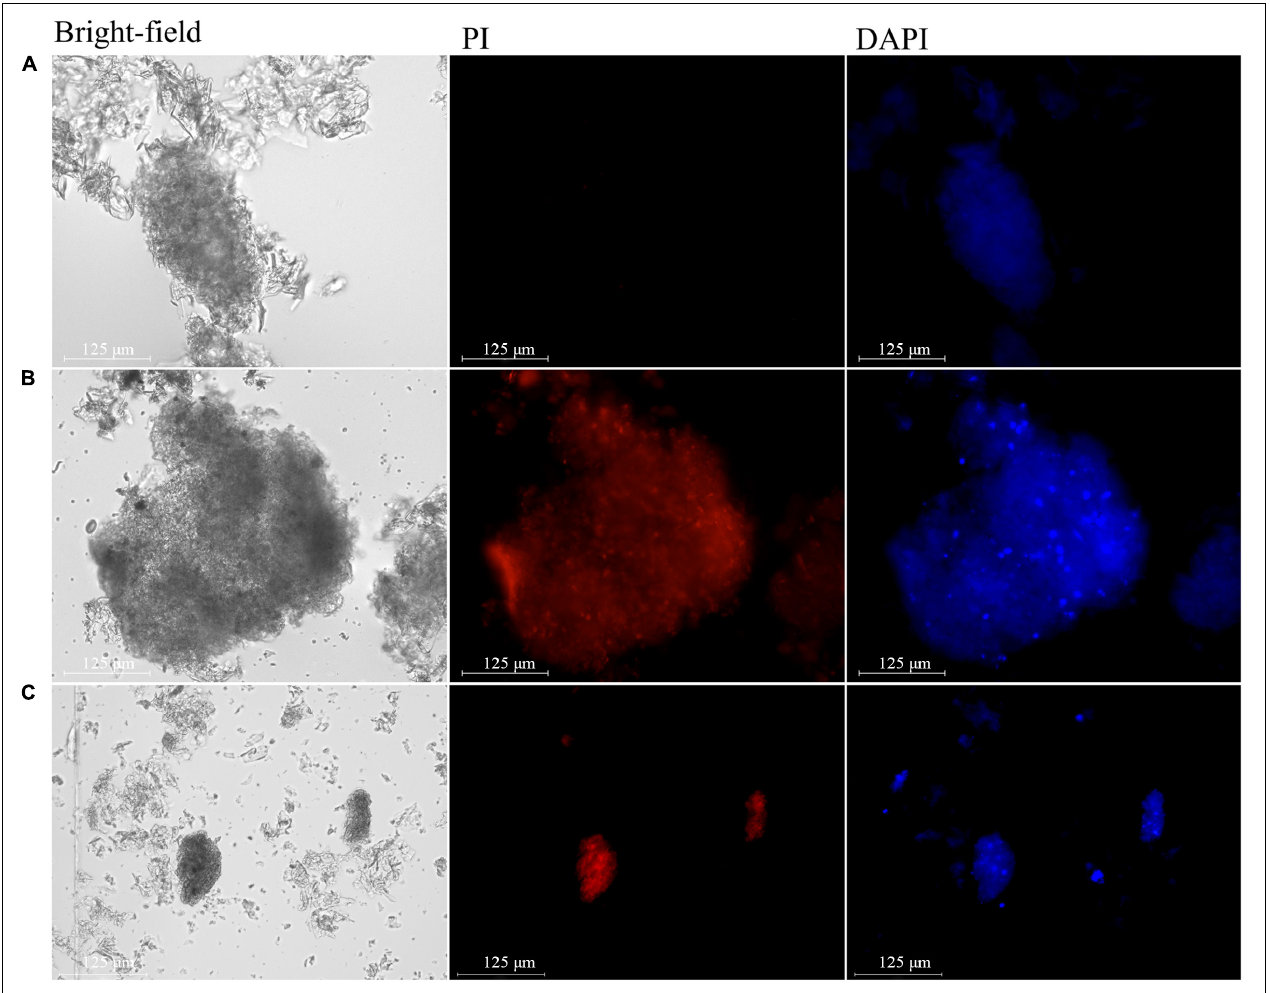
FIGURE 6 | Changes in the nucleus during programmed cell death (PCD). (A) Nucleus extracted from healthy pulp cells. Propidium iodide (PI) and 4 (cid:48) ,6-diamidino-2-phenylindole (DAPI) positively stained the nucleus. (B) Nucleus extracted from the flesh cells of apple with bitter pit. (C) Nucleus extracted from dexamethasone-treated flesh cells. The magnification of the objective of the microscope is 20